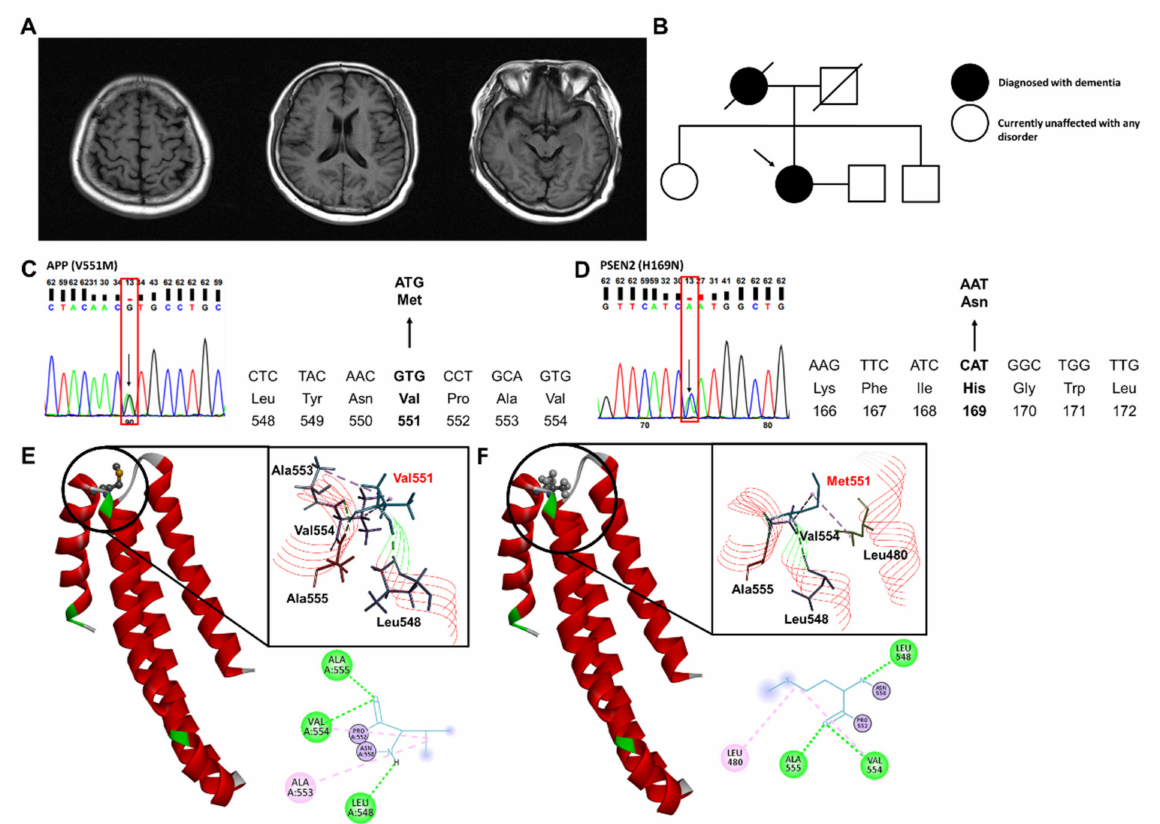
Figure 1. Brain imaging, family pedigree, and genetic analysis of a patient as well as prediction of the mutation-induced protein structure. ( A ) Axial FLAIR, coronal T2 images of brain MRI, with the arrows indicating the right hippocampal atrophy. ( B ) Family tree identifying the proband (arrow) with the APP and PSEN2 mutations. ( C , D ) Sanger sequencing of APP and PSEN2 variant. Heterozygous variants were indicated by a black arrow and red box. ( E , F ) The prediction of the mutation-induced alterations in the intramolecular interactions. 2D and 3D prediction of the structure and interactions between amino acids in the wild-type ( E ) and mutant APP ( F ). Green and pink dot lines represent hydrogen bond and alkyl interaction,